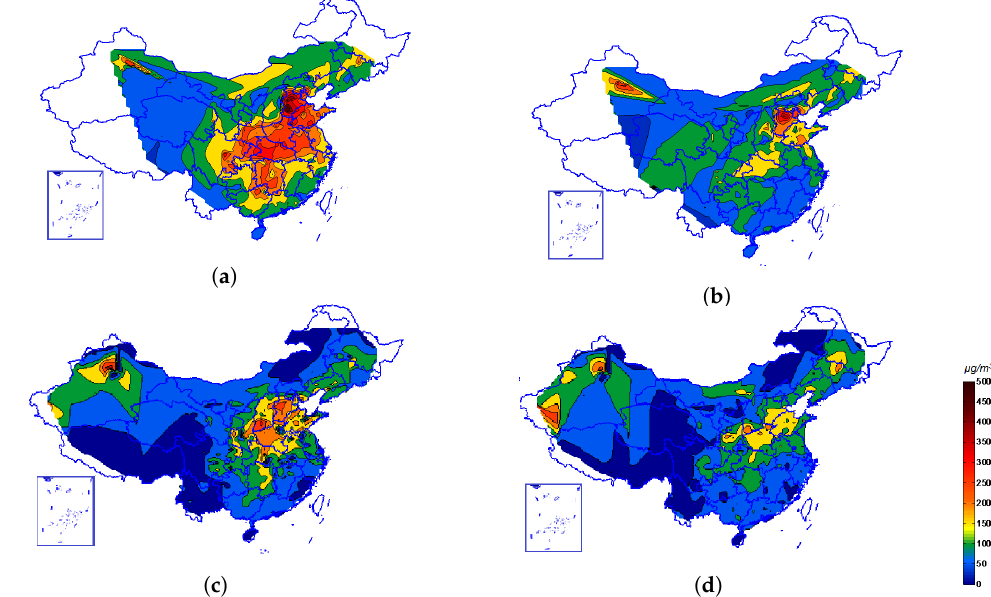
Figure 1. Contour maps of 90% quantiles ( µ g/m 3 ). ( a ) The contour maps of January 2014, ( b ) the one for December 2014, and ( c , d ) those of January and December 2019 respectively (the blank areas are due to the absence of